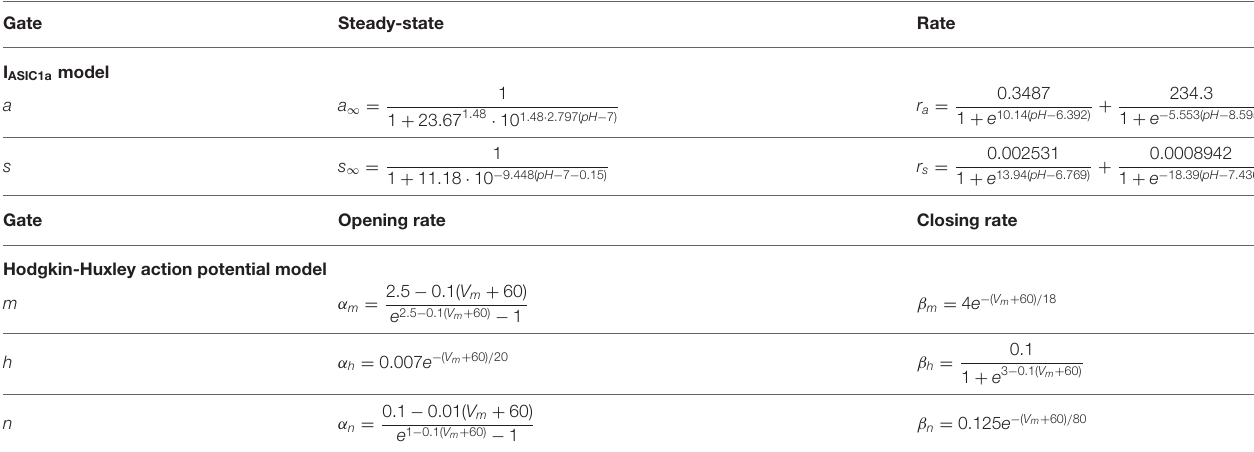
TABLE 1 | Model gating functions and parameters.